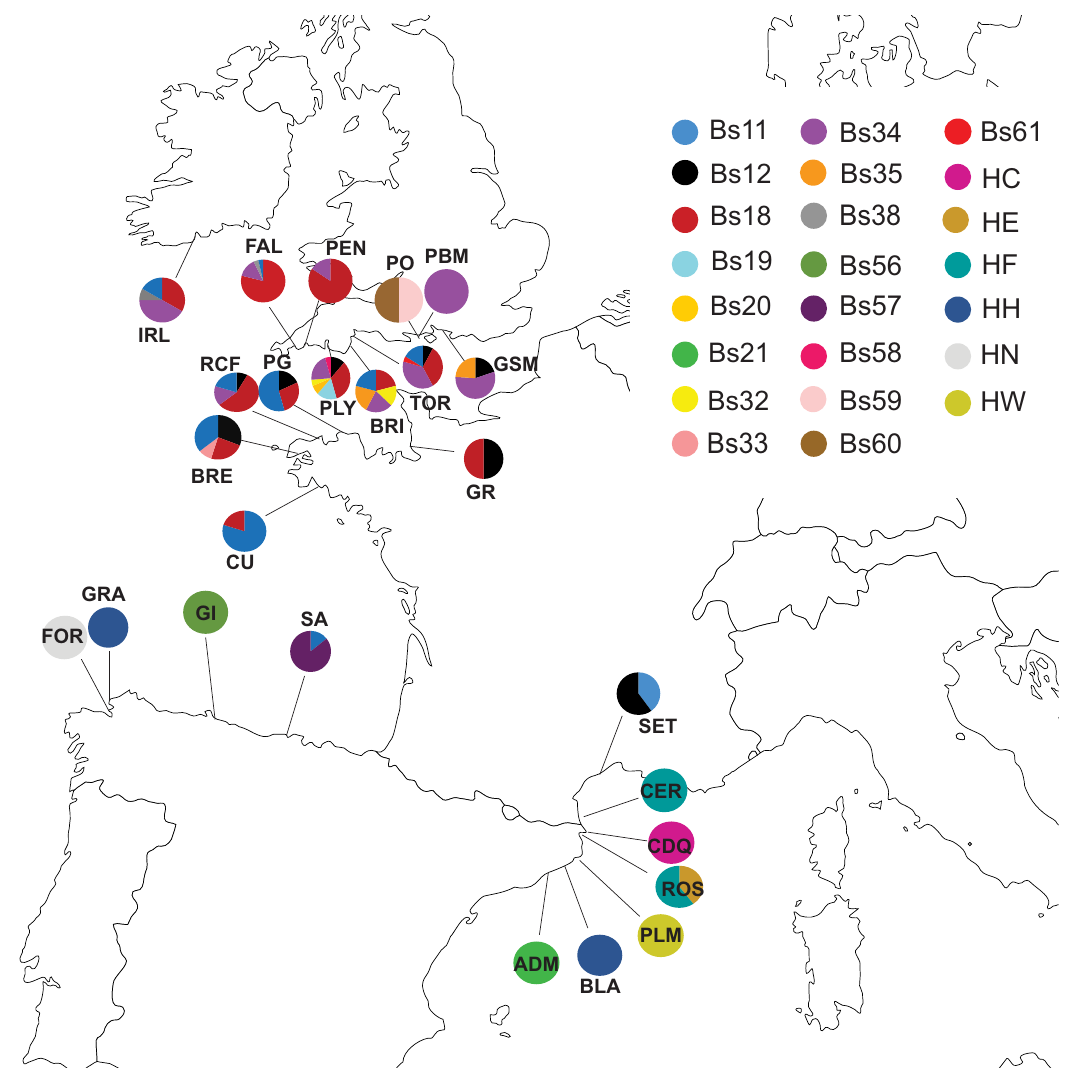
Fig 6. Clade E haplotype frequencies in the northeastern Atlantic and Mediterranean populations by the authors of this